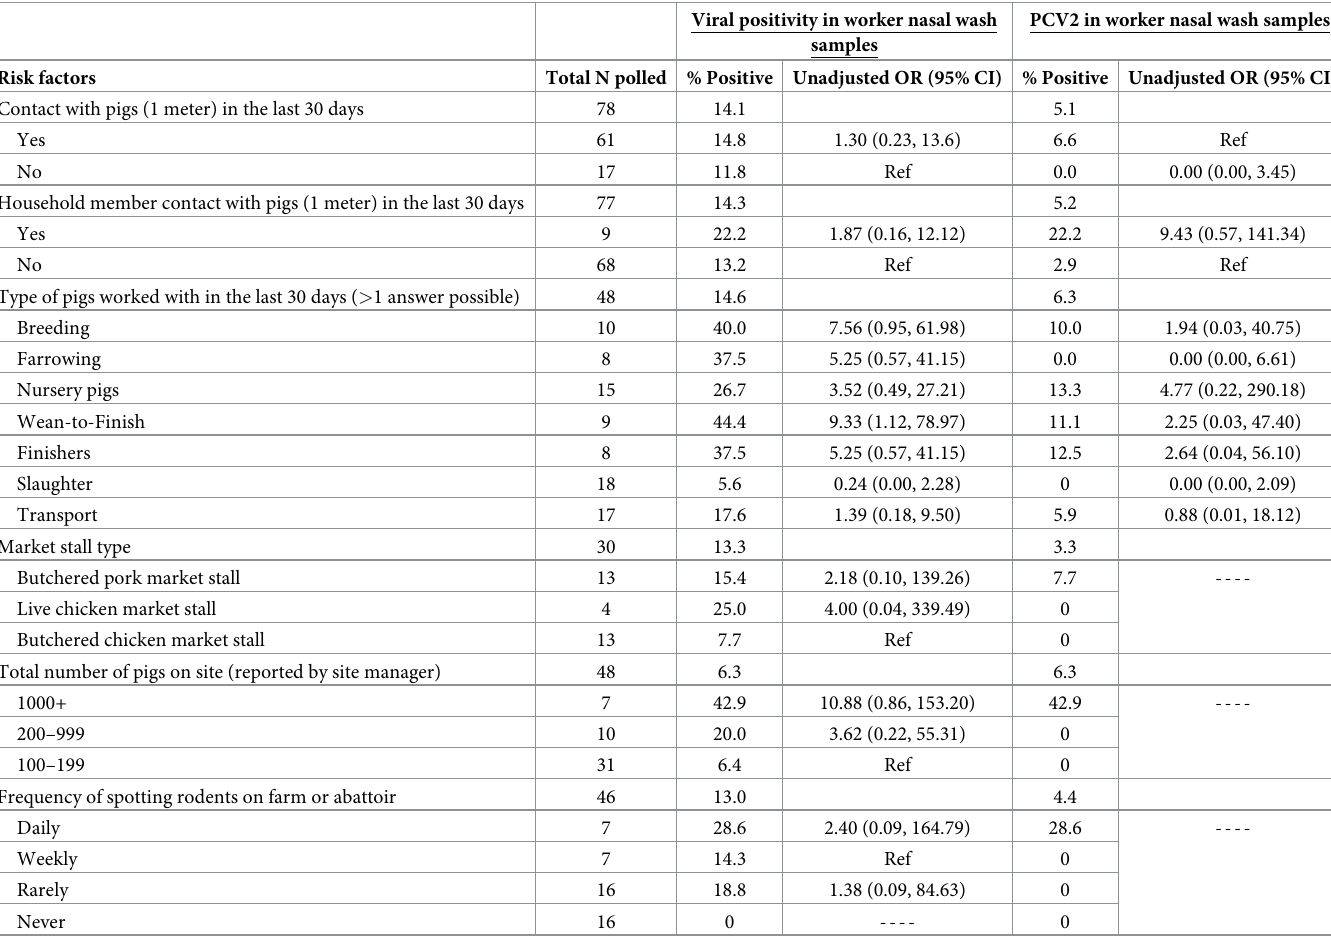
Table 4. Unadjusted odds ratios (OR) for risk factors associated with molecular detection of virus in 78 worker nasal wash samples collected from farms, abattoirs, and live animal markets in Sarawak, Malaysia in June and July of 2017. Viral positivity is defined as a positive rPCRor rRT-PCR result for at least one of the following viruses: adenovirus, coronavirus, enterovirus, encephalomyocarditis virus, influenza A-D, porcine circovirus 2, or porcine rotavirus